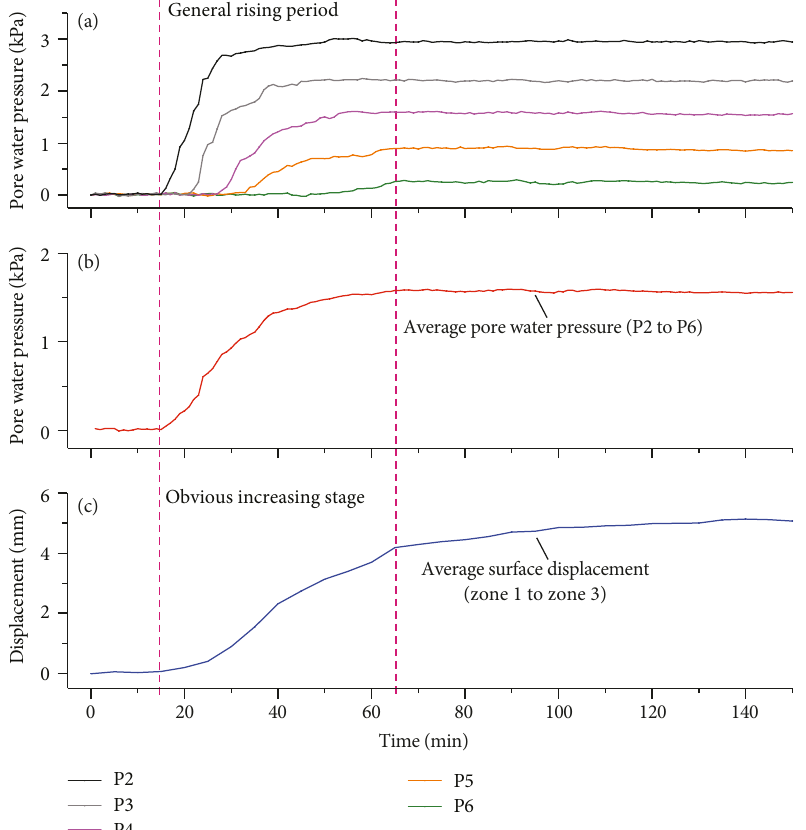
Figure 16: (a) Pore water pressure of P2 ~ P6 and (b) their average value and (c) average surface displacement versus